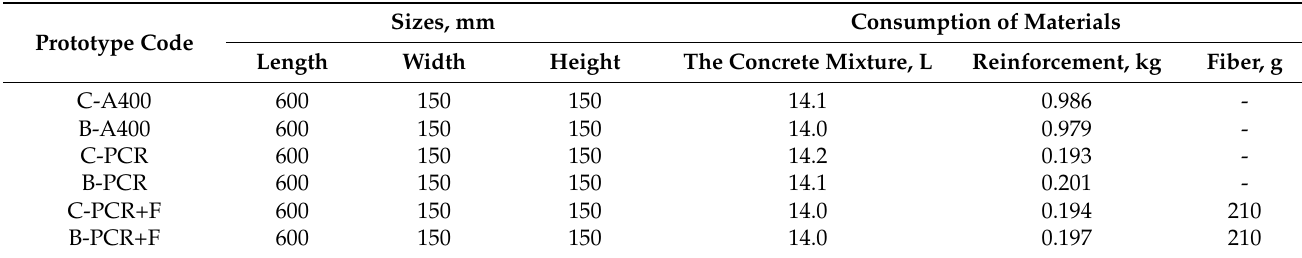
Table 8. Characteristics of prototypes.